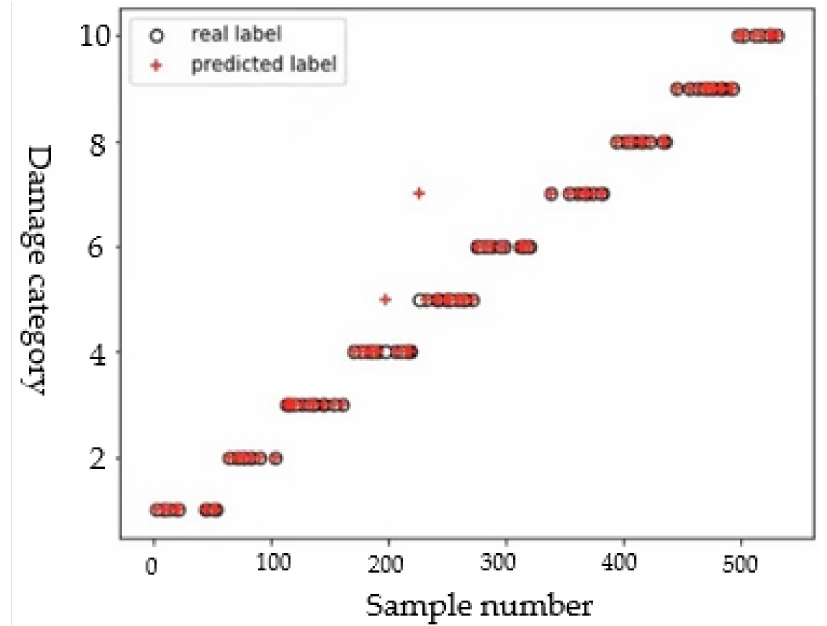
Figure 8. Scatter diagram of crack length.